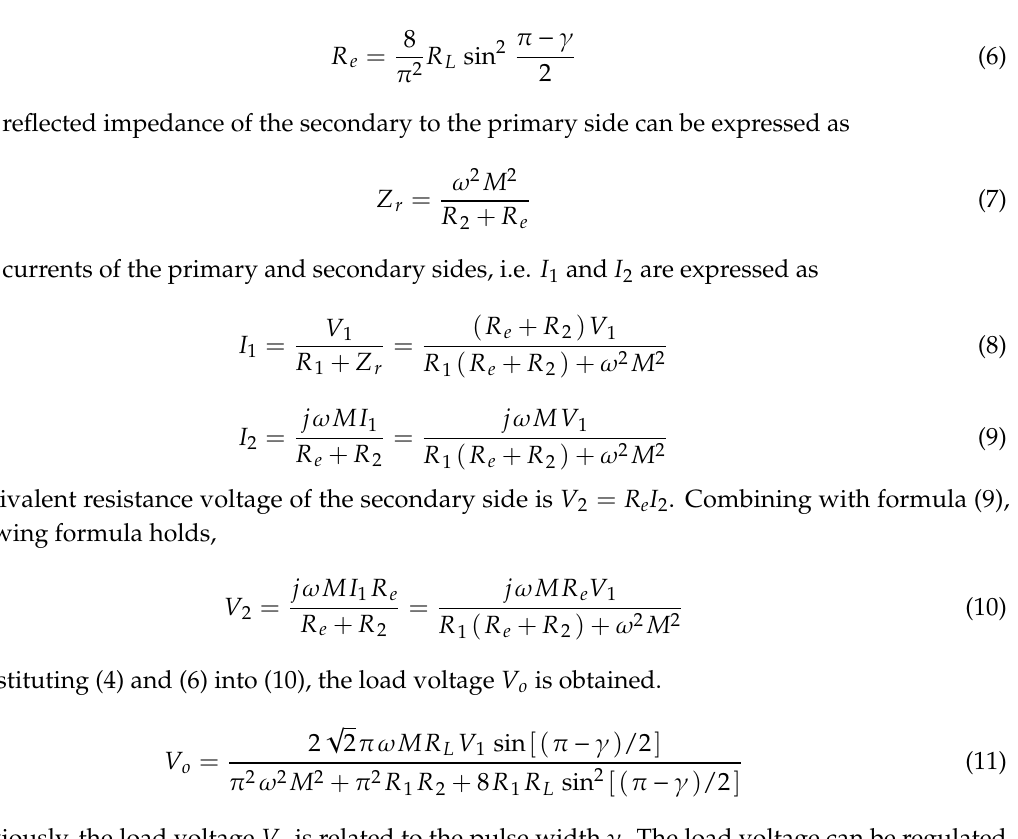
. Figure 5. Voltage waveforms of different power frequencies. In this paper, 85 kHz is selected as the primary side resonance frequency, when the information is forward transmitted; thus, 85 kHz and another frequency are required to represent the 1 and 0 signals, respectively. The second frequency cannot differ greatly from the resonant frequency 85kHz, otherwise the resonant compensation circuit generates a large amount of reactive